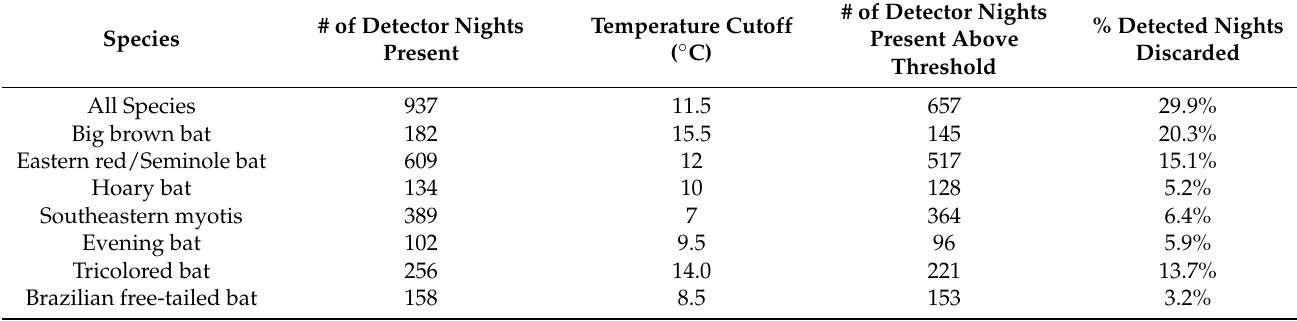
Table 2. Nights above the temperature threshold identified in [83] were retained for the analysis of habitat associations. Those below this threshold were discarded even if passes were recorded and identified to